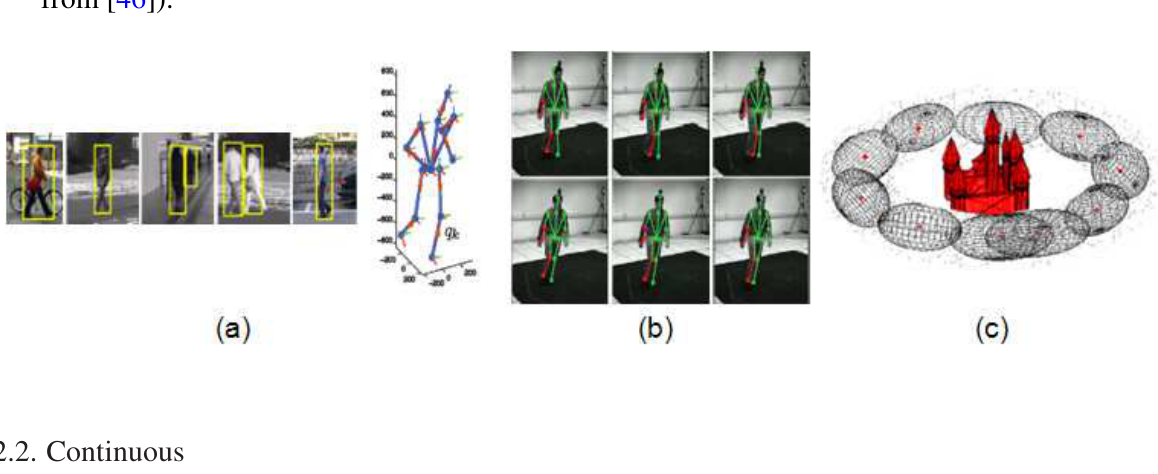
Figure 3. Viewpoint estimation examples: ( a ) First (discrete) and ( b ) second (continuous) phase of viewpoint estimation (frame extracted from [10]); and ( c ) Clusters of the camera pose space around the object which provide continuous viewpoint (frame extracted from